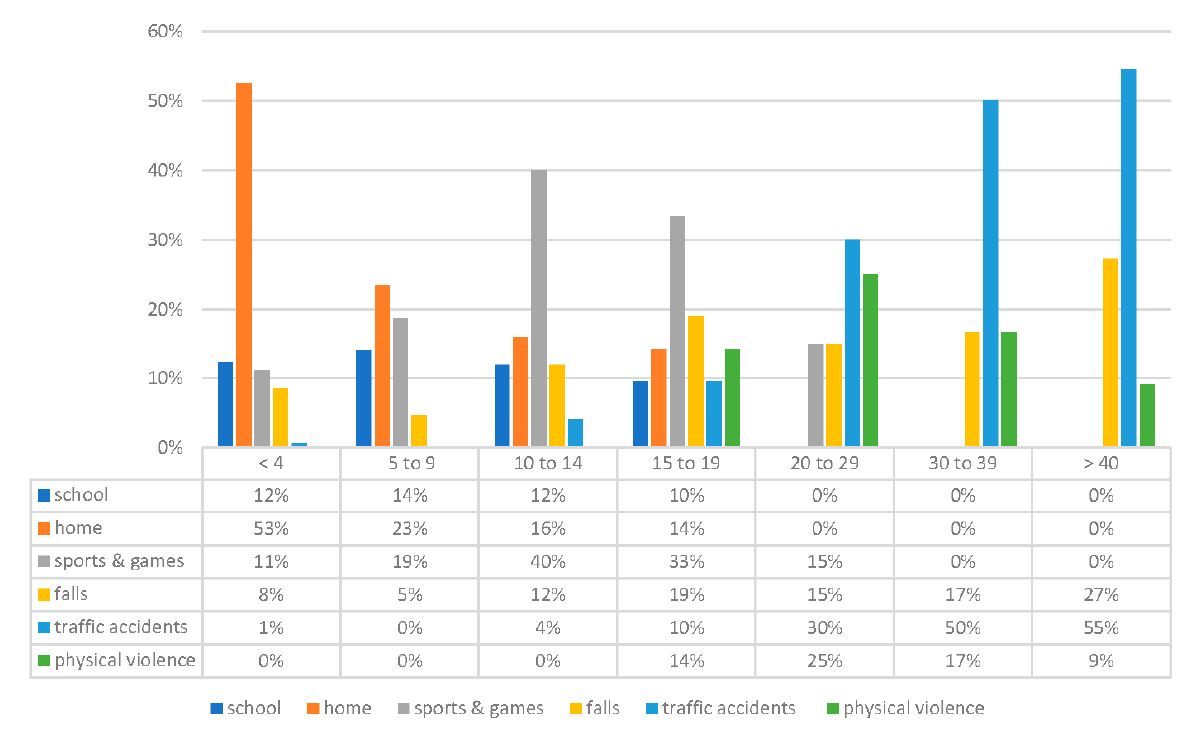
Figure 6. Etiology in relation to age.